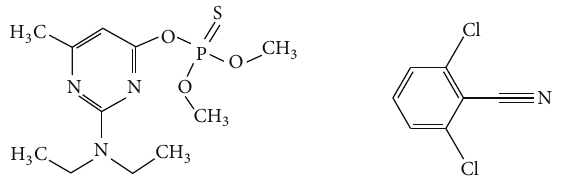
F 3: Comparison of Qtot values for pirimiphos-methyl and dichlobenil.